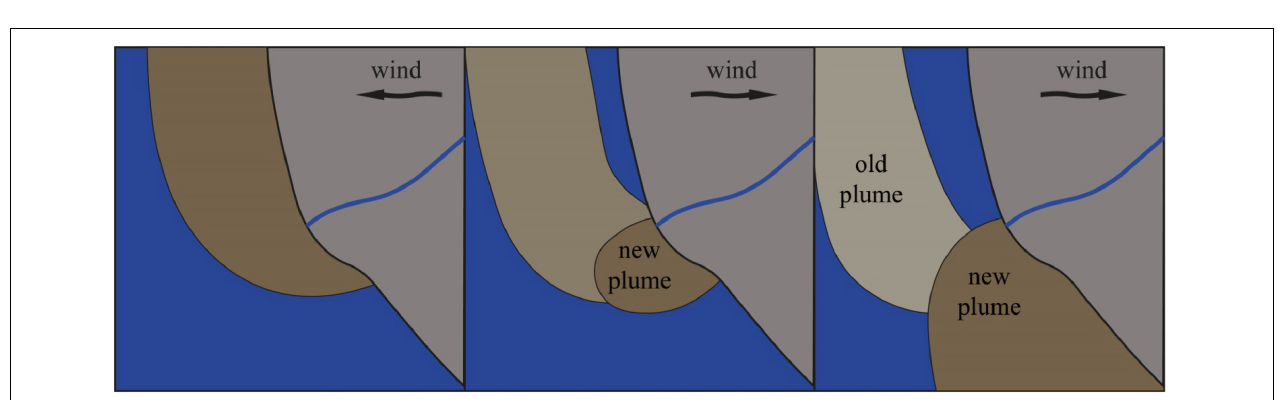
FIGURE 6 | The general scheme of the response of a small river plume to changes in upwelling/downwelling wind forcing.